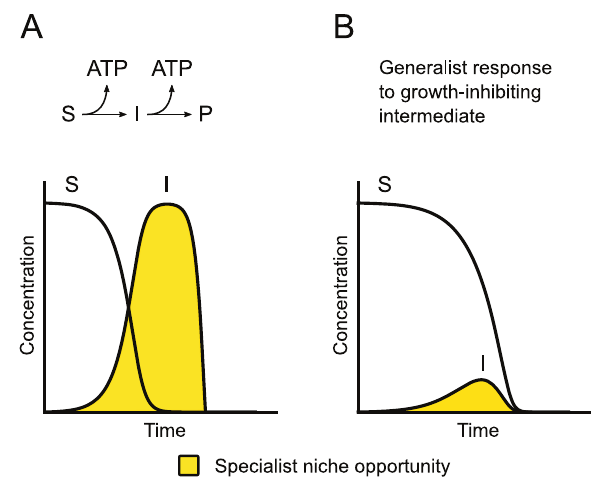
Fig. 1 Intermediate accumulation during operation of multi-step substrate consumption pathways. Consider a multi-step substrate consumption pathway where a substrate (S) is consumed via an intermediate (I) into an end product (P). A If a generalist performs the entire pathway but preferentially consumes S rather than I, then I will accumulate (yellow shaded region). This creates a niche for the specialist, where the specialist consumes I, and can enable the coexistence of the generalist and specialist via a cross-feeding interaction. B If phenotypic changes that improve the consumption of I are more readily available or bene fi cial to the generalist than the specialist, then this would reduce the duration of the niche for the specialist (yellow shaded region) and potentially disrupt the cross- feeding interaction.